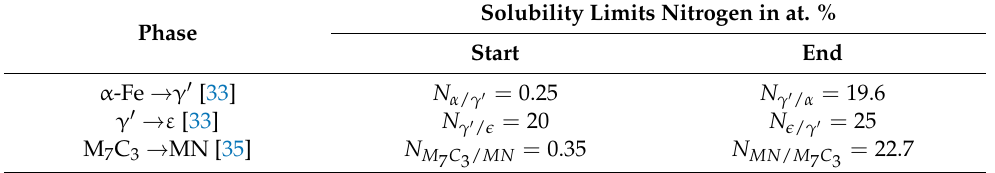
Table 3. Solubility limits at approximately 520°C, data from [33,35,36]. These were converted from wt.% to at.%. Phase